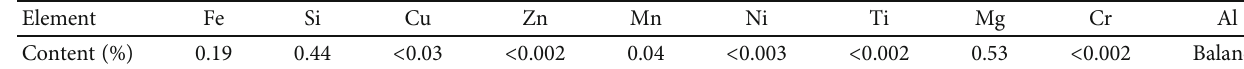
Table 1: Nominal composition of used AA3003 alloy.